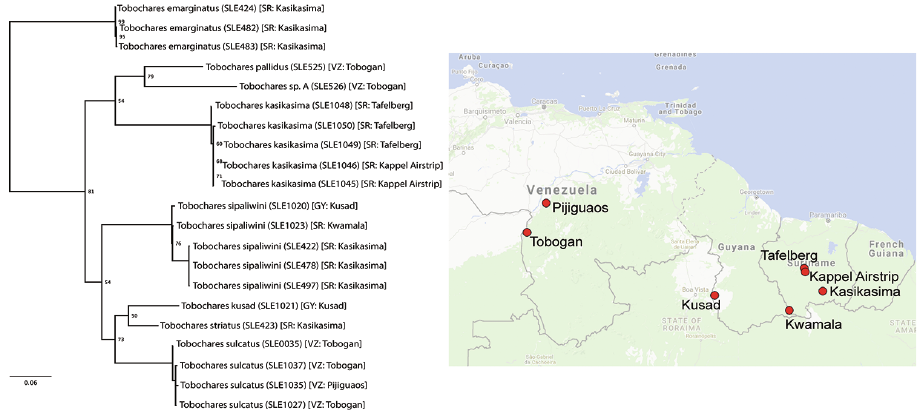
Figure 1. Maximum likelihood phylogeny of Tobochares spp. based on COI sequences, with map showing the localities of the sampled